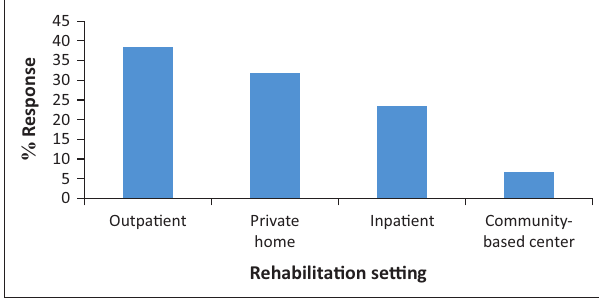
FIGURE 1: Rehabilitation setting